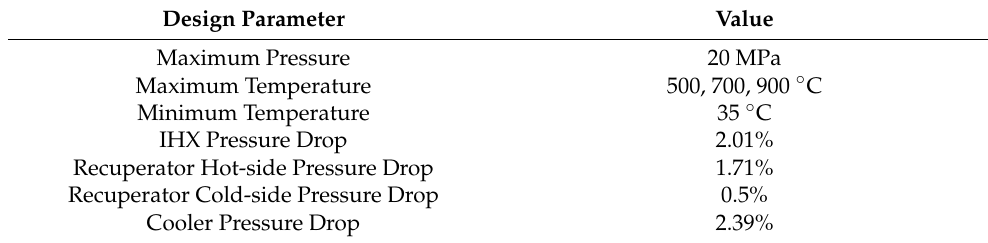
Table 1. Design Value for S-CO 2 Brayton Cycle.